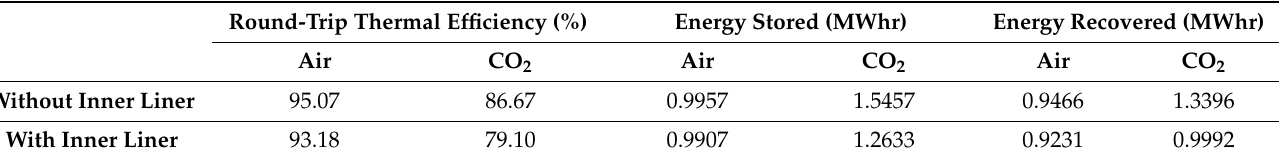
Table 8. Influence of the inner liner over thermal efficiency, and energy stored and recovered for air and CO 2 .